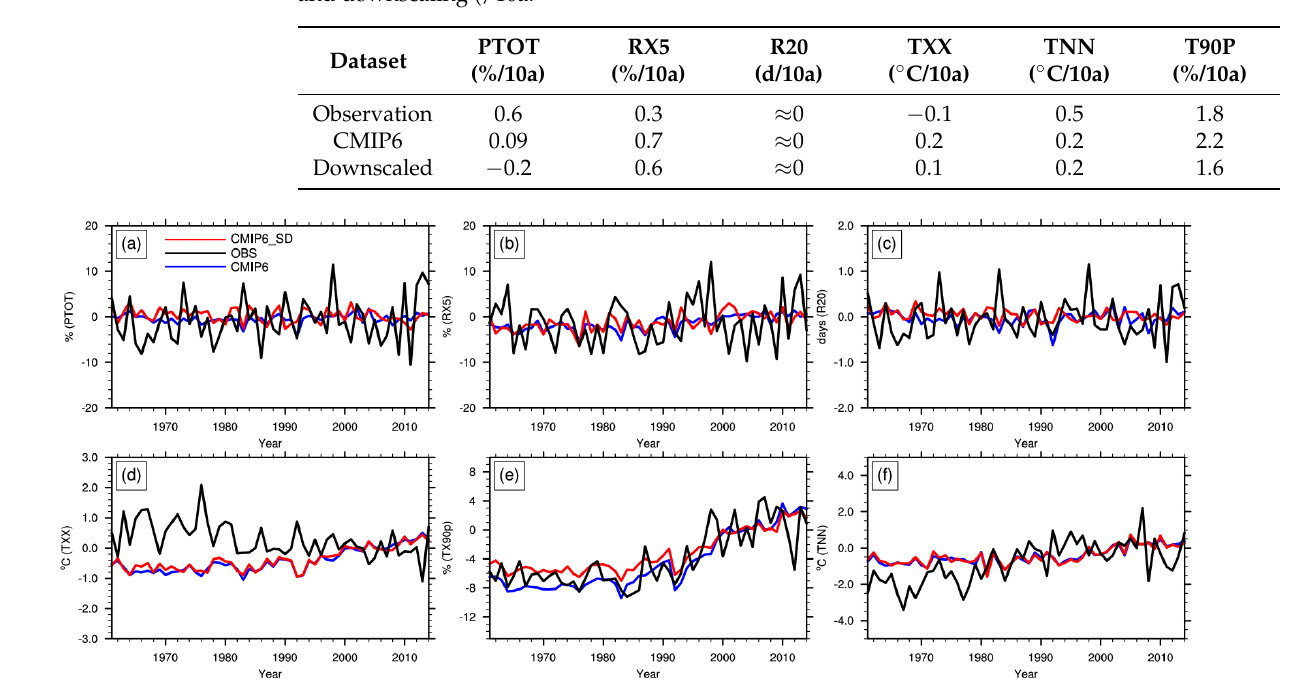
Figure 3. Extreme climate indices of PTOT ( a ), RX5 ( b ), R20 ( c ), TXX ( d ), TX90P ( e ) and TNN ( f ) over China during 1961–2014 for observation, CMIP6 MME and MME of downscaled dataset (black lines indicate observations, blue lines indicate CMIP6, and red lines indicate MME of downscaled dataset).